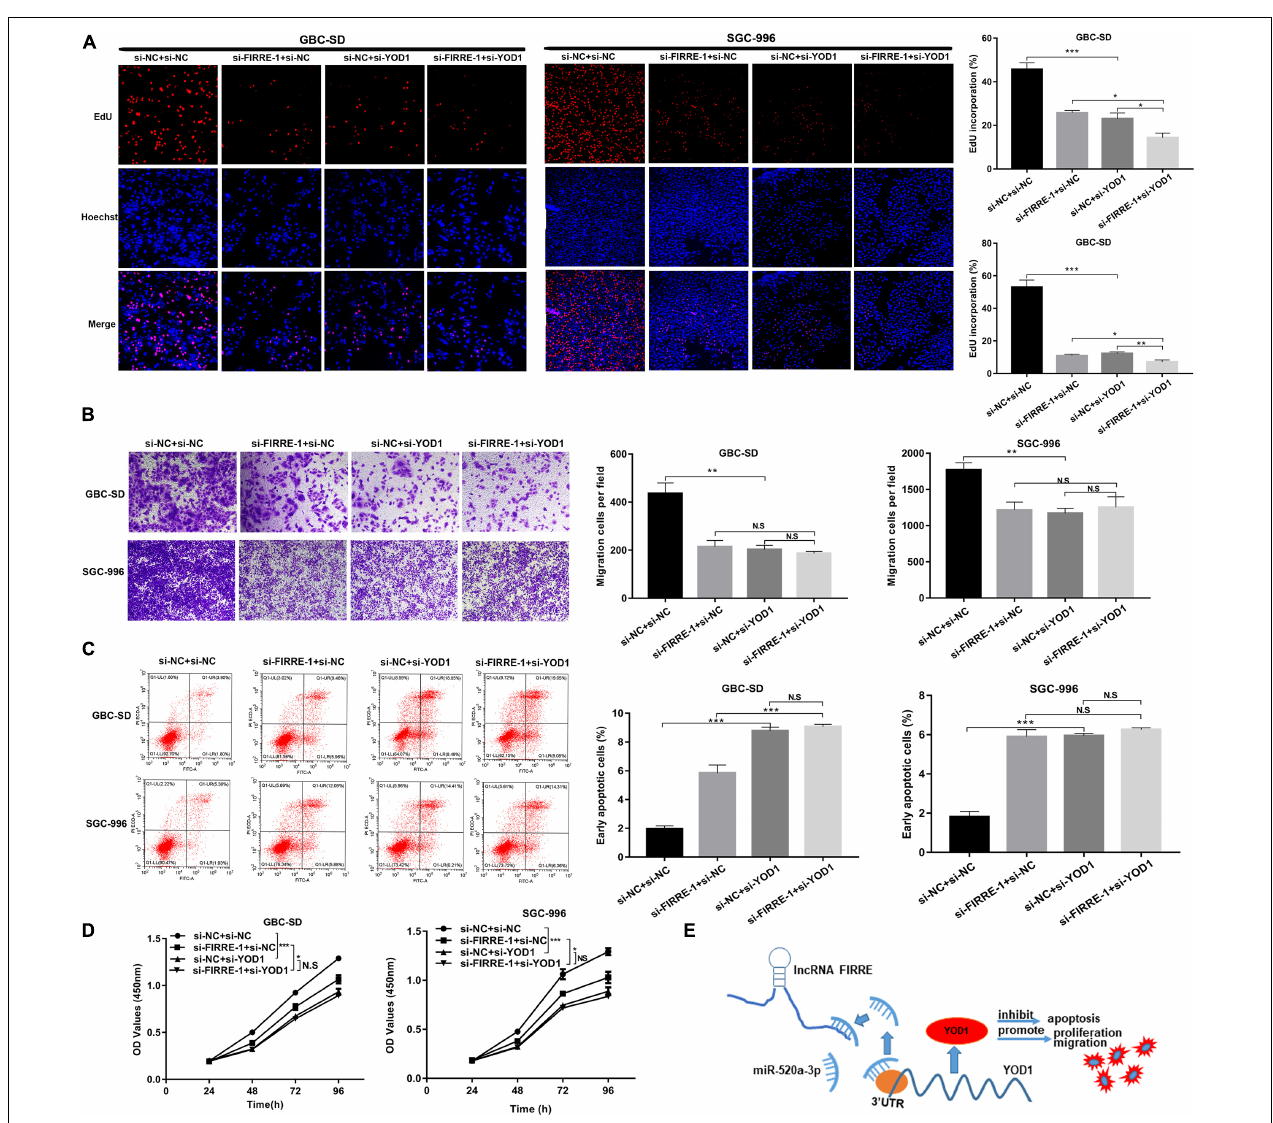
FIGURE 7 | The proliferation, migration, and apoptosis in GBC cells co-transfected with si-FIRRE-1 and si-YOD1. (A,D) The proliferation ability of GBC-SD cells and SGC-996 cells co-transfected with si-FIRRE-1 and si-YOD1 were determined by CCK-8 and EdU assays. (B) The migration ability was examined by transwell assays. (C) The apoptosis of co-transfected GBC-SD cells and SGC-996 cells was analyzed by flow cytometric analyses. (E) Schematic diagram of how FIRRE promotes GBC tumorigenesis and progression. * p < 0.05, ** p < 0.01, *** p <